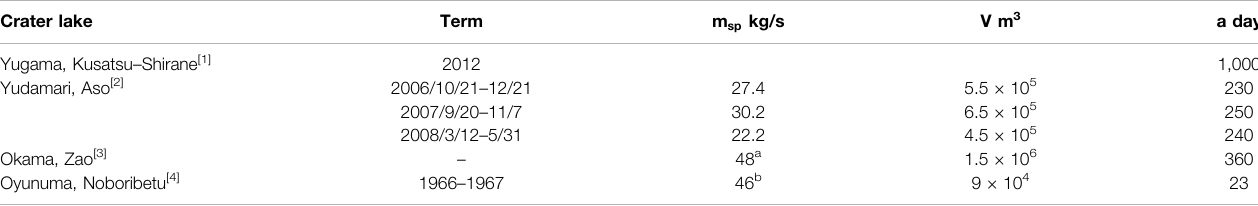
TABLE 2| Summaryoftheseepage fl ux m sp ,watervolume V ,and timeconstant a foreach volcano.Numbersrefertothefollowingreferences:[1] Hirayamaet al.(2020),[2] Terada et al. (2012), [3] Kato (1960), and [4] Fukutomi et al. (1968). Crater lake Term m sp kg/s V m 3